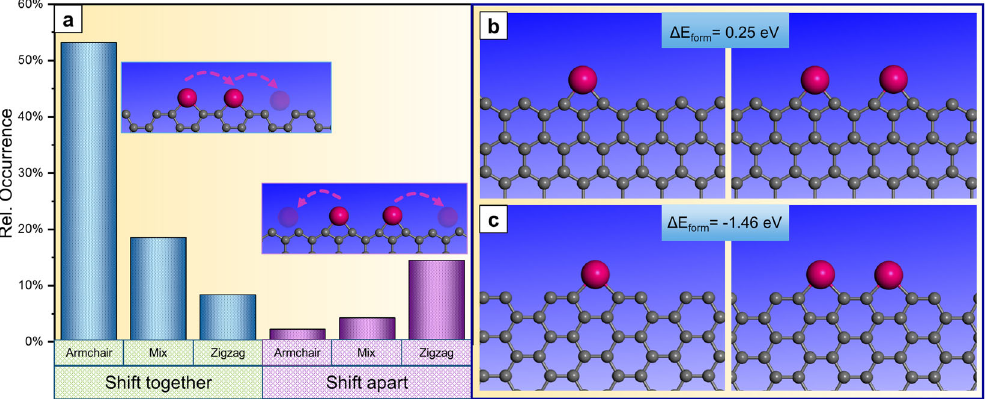
Fig. 8 Analysis of diffusion and relative binding energies for Sn monomers and Sn dimers at different graphene edges. a The relative occurrence diffusion behavior (as a pair or splitting) for different Sn dimer/edge con fi gurations under electron irradiation. b The optimized con fi gurations of Sn monomers and dimers at a zigzag edge. c The optimized con fi gurations of Sn monomers and dimers at an armchair edge. Reproduced with permission from Wiley-VCH GmbH 48